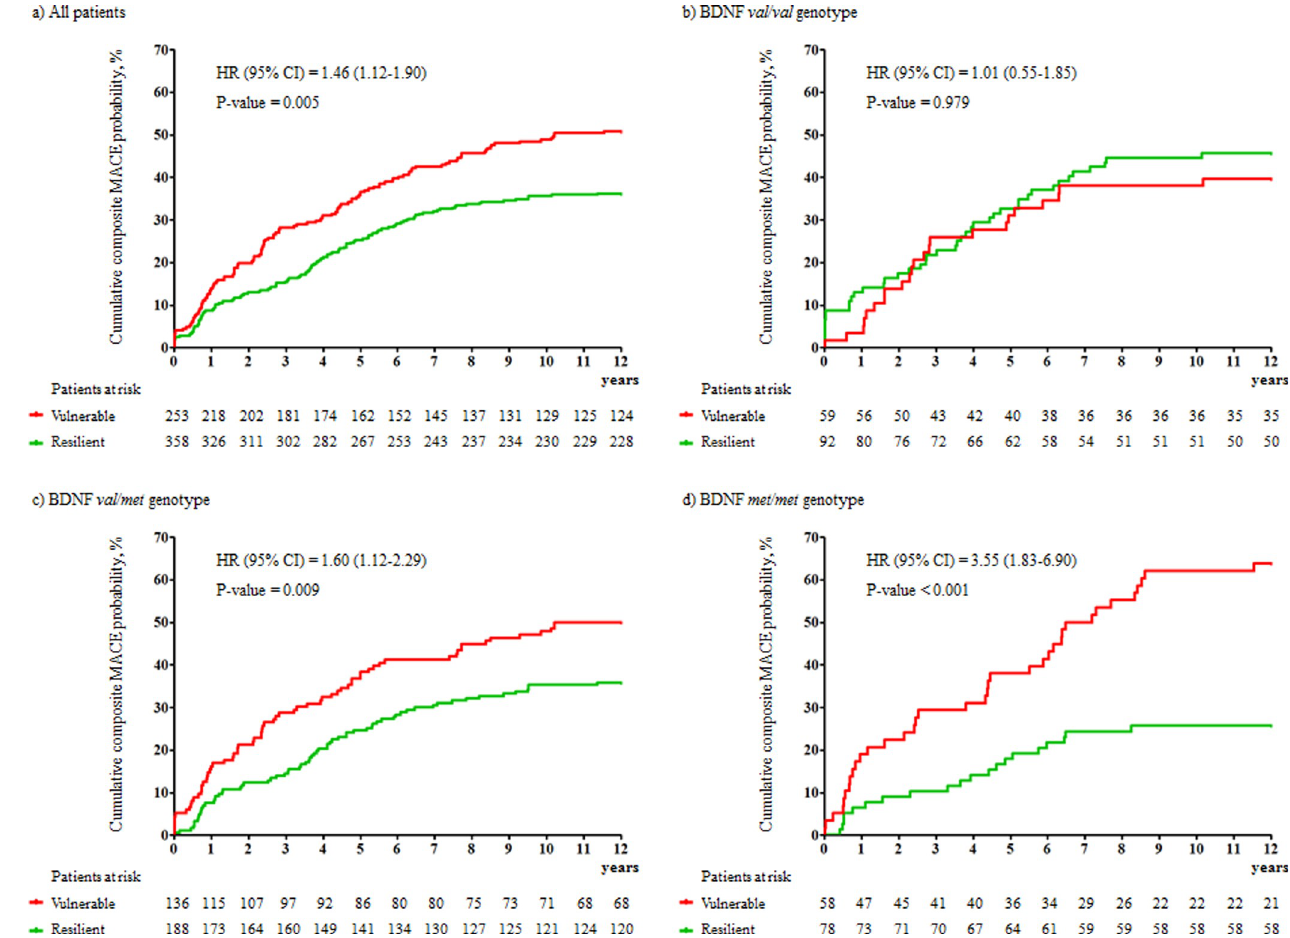
Fig 2. Associations of personality cluster with cumulative incidence (%) of composite major adverse cardiac events (MACE) by brain derived neurotrophic factor (BDNF) val66met polymorphism. Hazard ratios (95% confidence intervals) [HR (95% CI)] using Cox proportional hazards models were calculated after adjustment for age, gender, education, accommodation, Beck Depression Inventory scores, previous history of depression, hypertension, diabetes, hypercholesterolemia, obesity, smoking, past history of ACS, ACS diagnosis, Killip class, left ventricular ejection fraction, and serum levels on troponin I, creatine kinase-MB, and high sensitivity C-reactive protein at baseline. Multiplicative interaction terms between personality cluster and BDNF val66met polymorphism on composite MACE were statistically significant (P-value = 0.001). Figure a) denotes the association between personality cluster and composite MACE in all participants, and other Figures denote those by BDNF polymorphism: b) val/val, c) val/met, and d) met/met